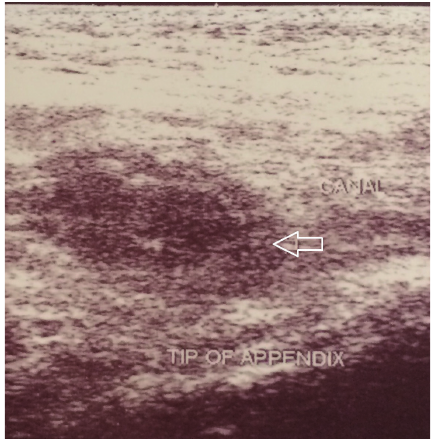
Figure 2: Ultrasound study shows right inguinal canal with the tip of appendix herniated into the canal (white arrow).